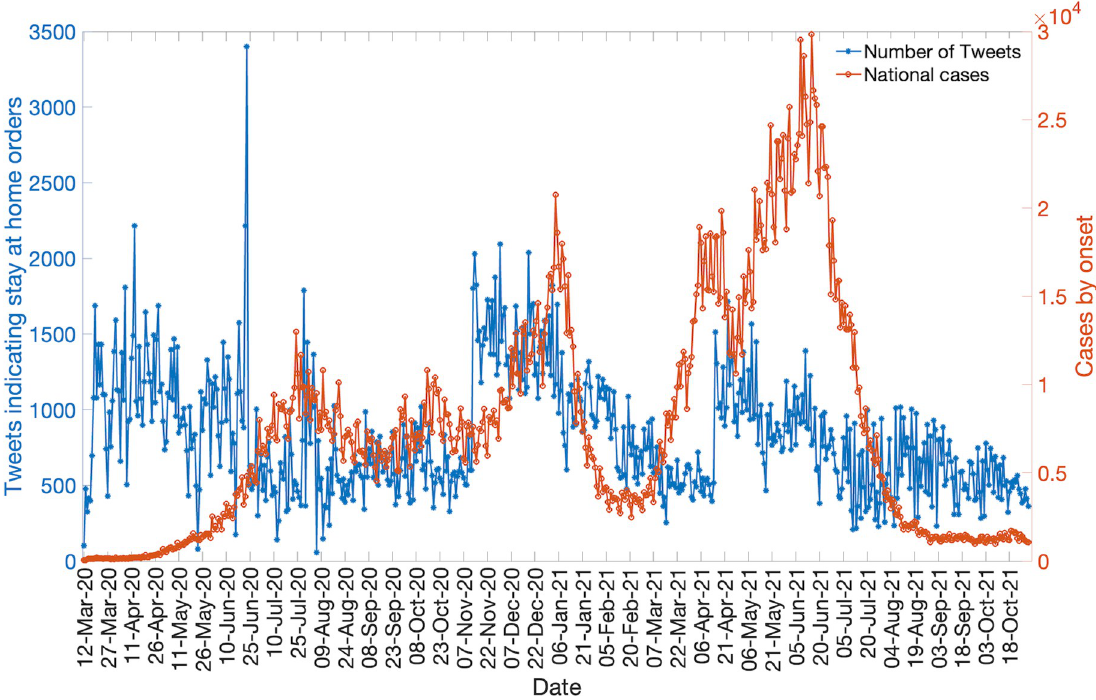
Fig 14. The daily number of tweets indicating stay at home orders (blue) and the daily number of new COVID-19 cases based on the dates of symptom onset (orange) as of October 31, 2021.